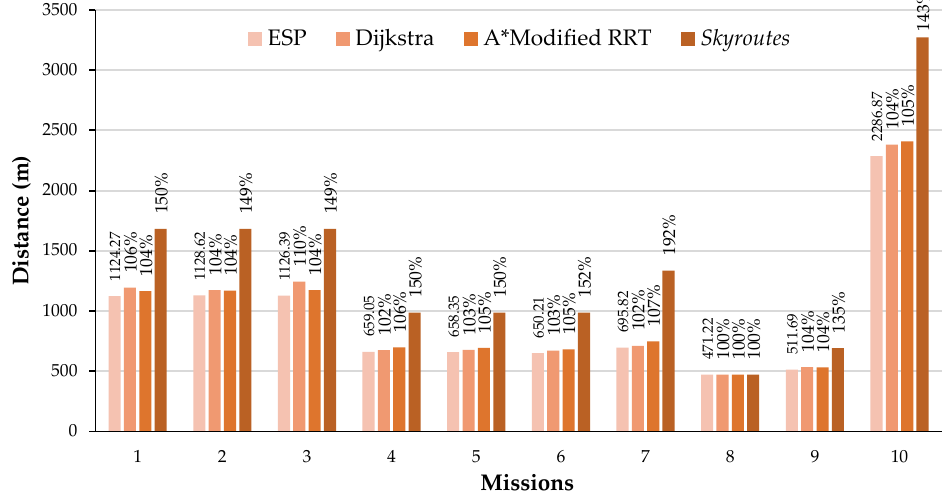
Figure 12. Generated trajectory length compared to ESP for all missions.